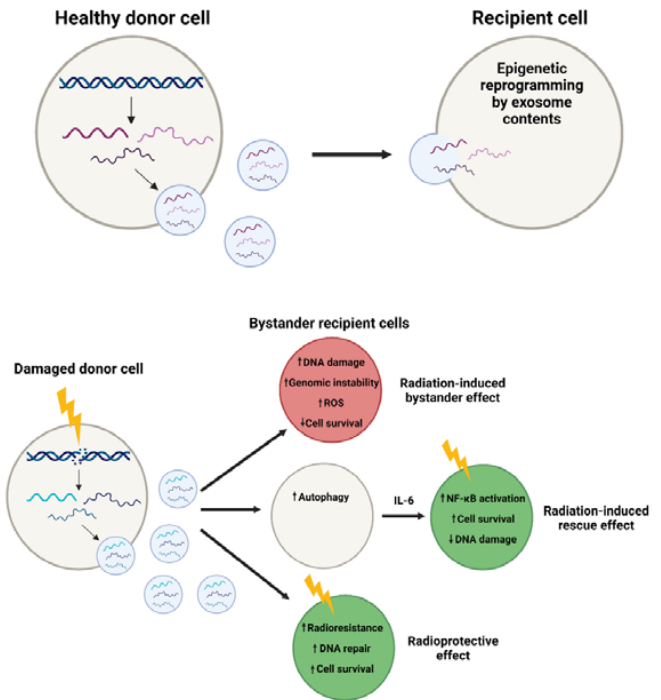
Figure 2. Radiation-derived exosomes can influence damage responses. Under normal conditions, RNA is packaged into exosomes and is taken up by recipient cells to allow intercellular communica- tion. Irradiation of donor cells alters exosome contents. Uptake of these radiation-derived exosomes leads to various bystander effects in recipient cells. Created with